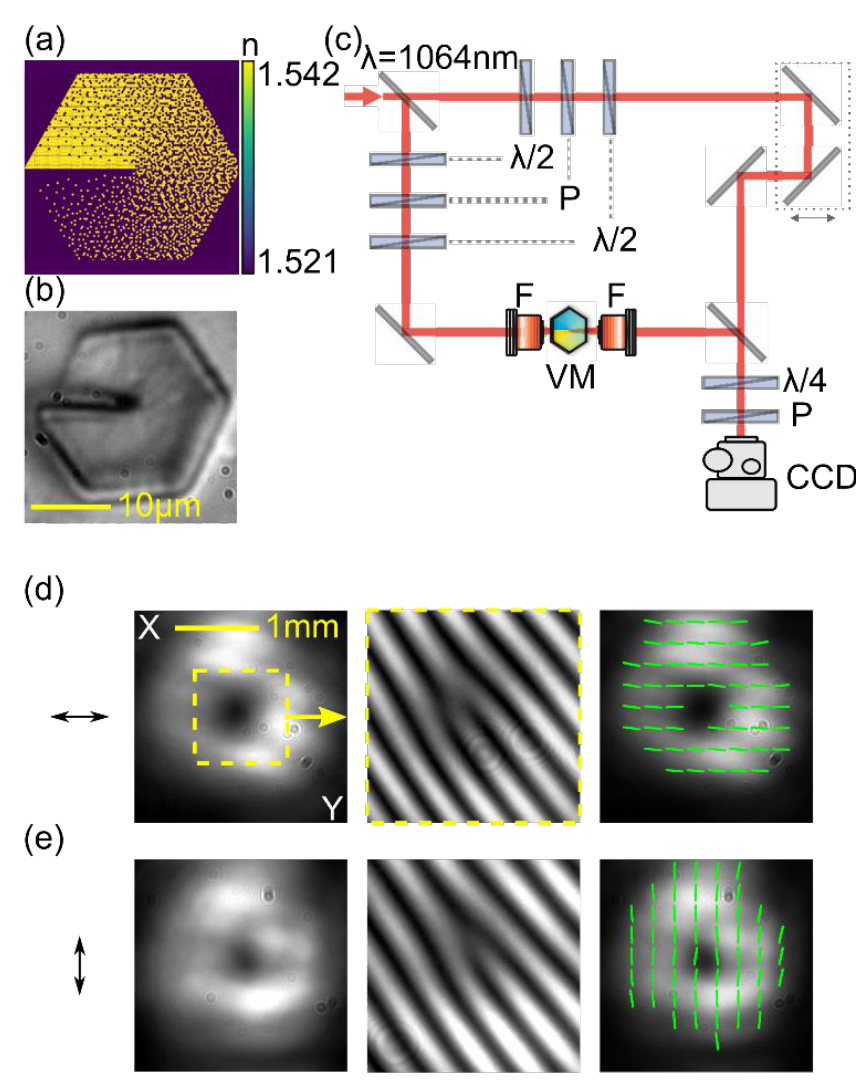
Figure 1. ( a ) Schematic representation of the vortex nanostructure with 101 rods on the diagonal. Yellow (violet) dots represent high (low) refractive index rods; ( b ) Photo of the examined structure; ( c ) Sketch of the experimental setup: VM—vortex mask, F—lens, CCD—digital camera; ( d ) Experi- mental results of Gaussian beam transformation through the examined structure. The left, middle, and right panels represent the output intensity distribution, phase singularity within the marked area, and polarization distribution, respectively. Obtained for the wavelength of λ = 1064 nm and linear po- larization (horizontal direction—schematically marked by the black arrow); ( e ) Experimental results of Gaussian beam transformation for a linearly polarized input beam, vertical direction—orthogonal to the input beam in ( d ). The proper operation of the VM was verified for two states of linear polarization—horizontal and vertical, as presented in Figure 1d,e. The left panels of Figure 1d,e show an intensity distribution of the generated vortex. Independently of the input polarization, they exhibit a typical doughnut-shaped pattern. The photos in the middle panels of Figure 1d,e result from a vortex interference with a reference beam. A characteristic fork-type pattern phase singularity with one additional interference fringe indicates the charge of the vortex of m = 1 for both polarizations of the input beam. The polarization distribution of the generated vortex beam was determined using the Stokes method. We found Stokes vectors for every pixel of a CCD camera for each output beam polarization. The calculations of the Stokes vector were based on six pictures of the